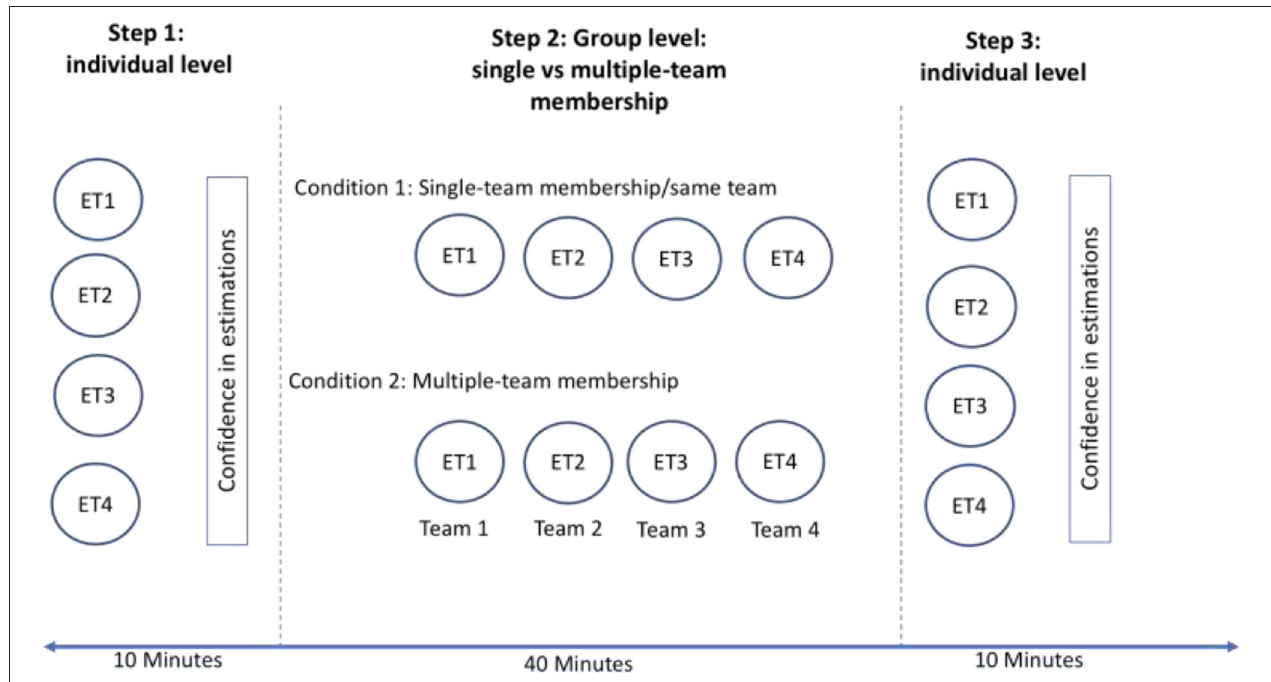
FIGURE 1 | Experimental design. ET1, estimation task 1; ET2, estimation task 2; ET3, estimation task 3; ET4, estimation task 4; in the single team membership condition participants performed all estimation tasks in the same team; in the multiple team membership condition participants had a different team for each of the four estimation